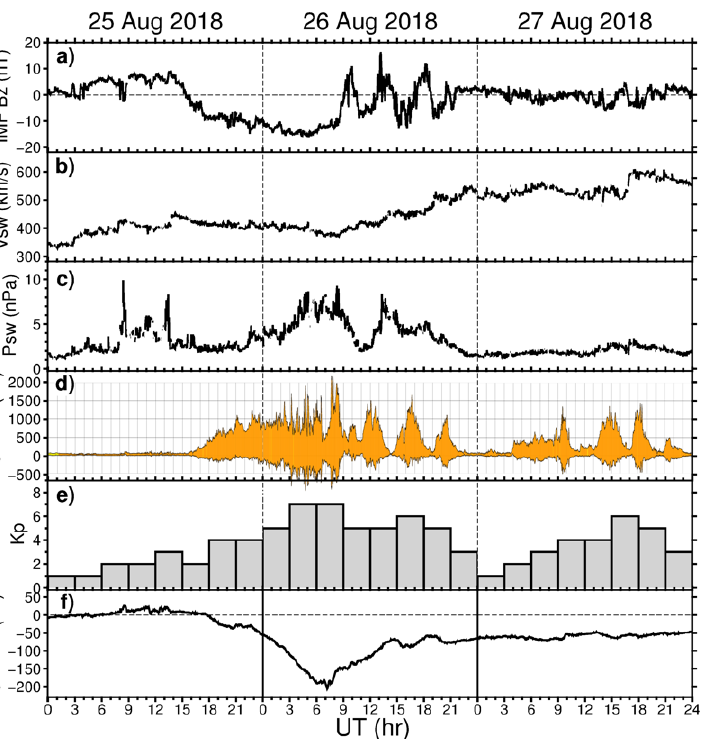
Figure 1. Geomagnetic conditions during 25–27 August 2018: ( a ) IMF Bz component, ( b ) velocity and ( c ) dynamic pressure of the solar wind, ( d ) auroral electrojet index AE, ( e ) Kp index, and ( f ) SYM-H index.